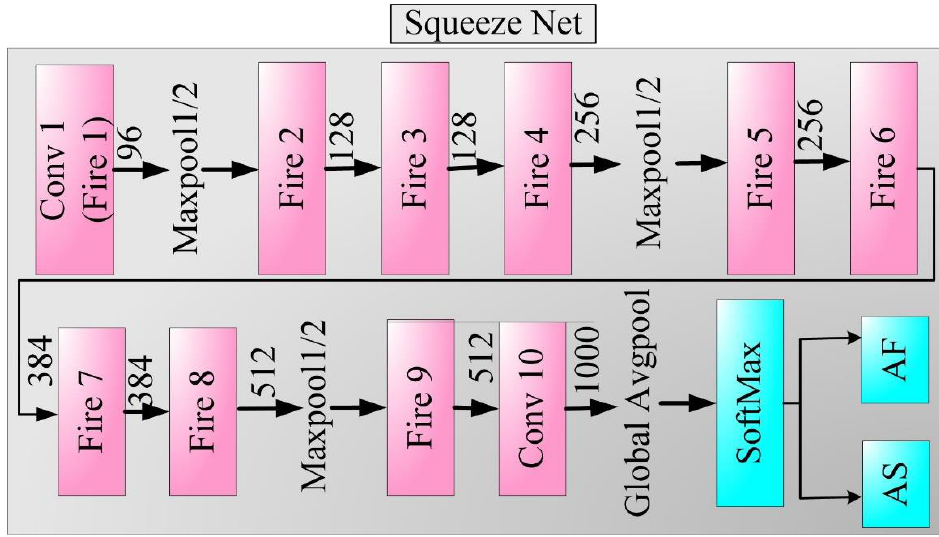
Figure 11. SqueezeNet architecture.